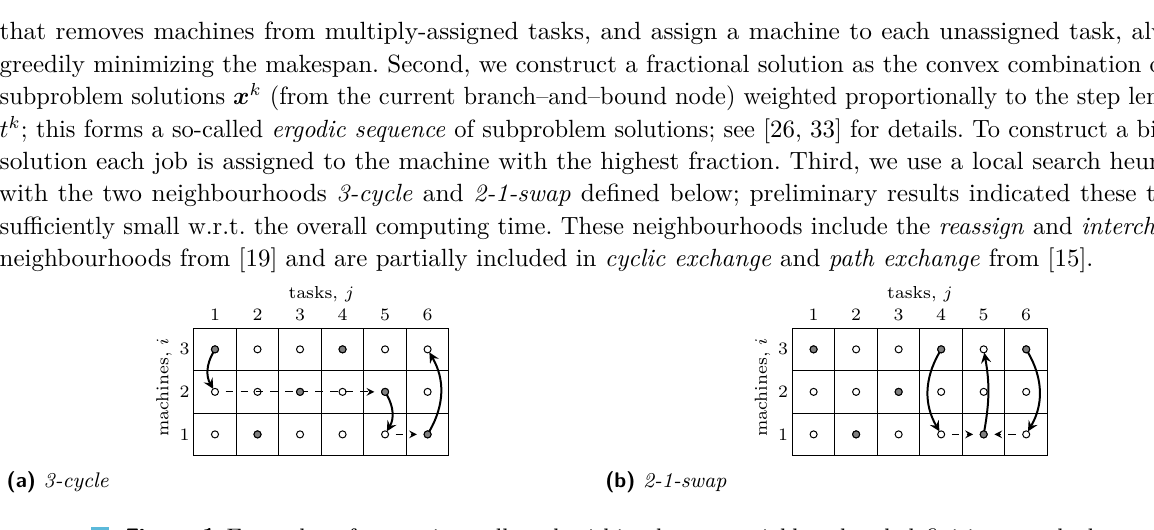
Figure 1 Examples of operations allowed within the two neighbourhood definitions; each dot represents a variable x ij and a filled dot encodes the value